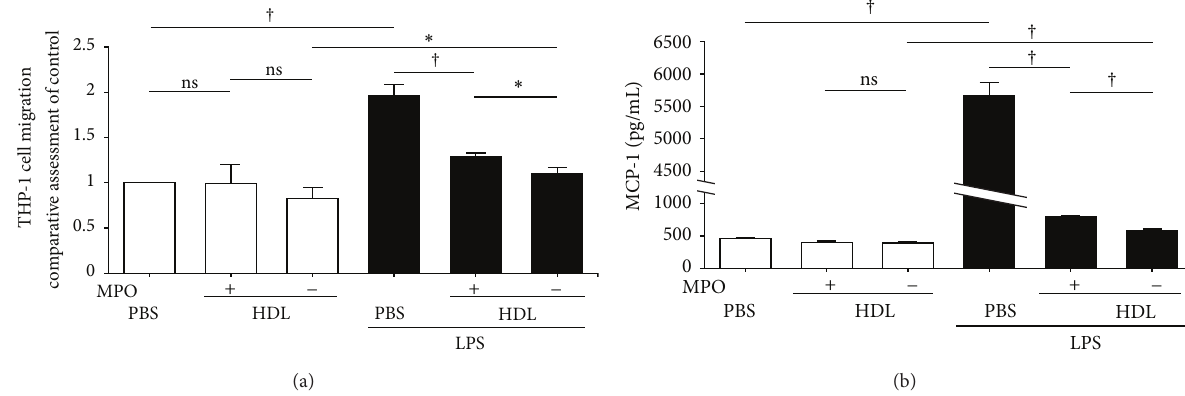
Figure 4: Effects of HDL treatment with and without MPO on THP-1 cell migration. The effects of HDL on THP-1 cell migration were determined using PET membranes (8 𝜇 m pore size) (a). HUVECs were cultured in medium containing (black columns) or lacking (white columns) LPS with MPO-treated (+) and MPO-untreated ( − ) HDL or without HDL (PBS) at 37 ∘ C for 16hrs. The media used for HUVEC culture were then supplied to a THP-1 cell migration assay. The THP-1 cell migration rate in the absence of LPS and HDL (PBS) was defined as 1. The results are means ± SD of three independent experiments. ∗ 𝑃 < 0.05 , † 𝑃 < 0.01 . ns: nonsignificant. MCP-1 concentrations in those media used for THP-1 cell migration assay were measured in triplicate by ELISA kit (b). The results are means ± SD of one experiment. † 𝑃 < 0.01 . ns: